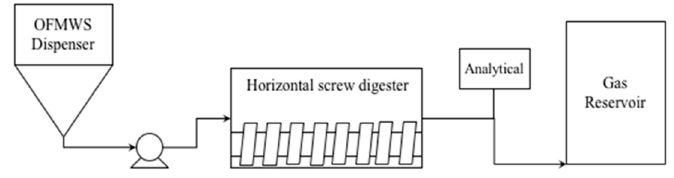
Figure 2. Pilot plant for dry-type anaerobic digestion in continuous configuration.